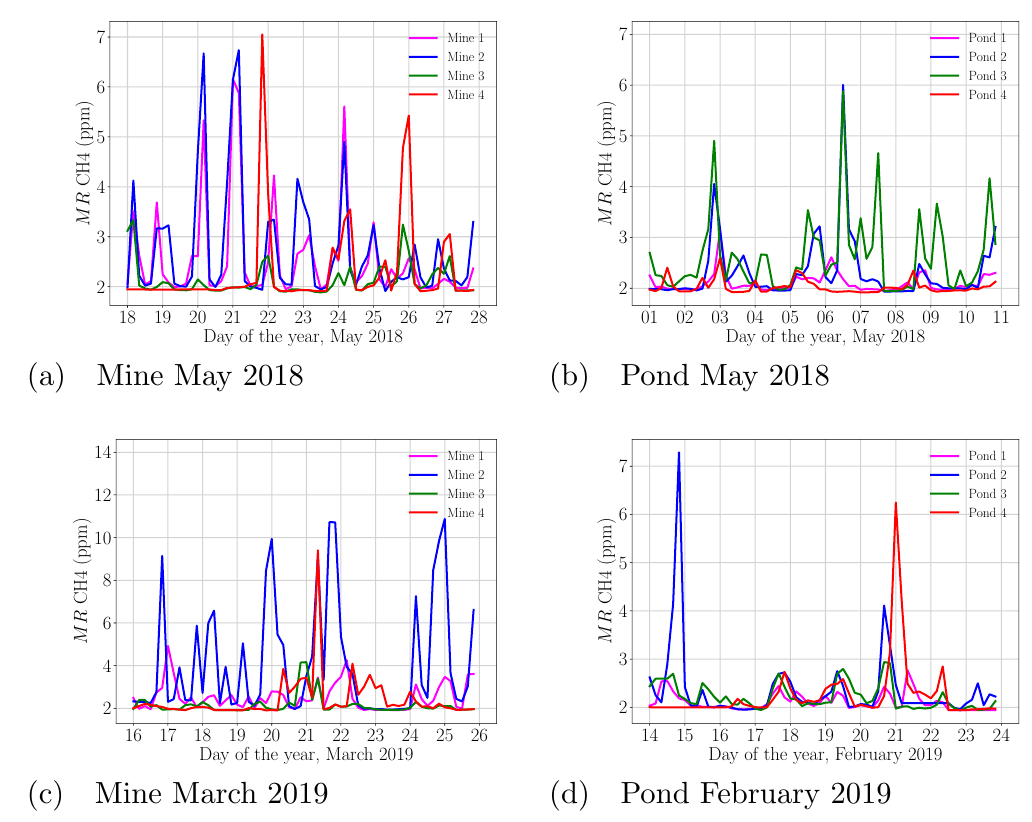
Figure 2. Time series of LGR-measured four-hour-averaged near-surface-level mixing ratios MR of methane at four observation locations during the M18, P18, M19 and P19 field campaigns indicated in Figure 1d; numbers on the horizontal axis indicate the start of the day using local standard time (LST = UTC − 7); ( a ) Mine May 2018; ( b ) Pond May 2018; ( c ) Mine March 2019; ( d ) Pond February